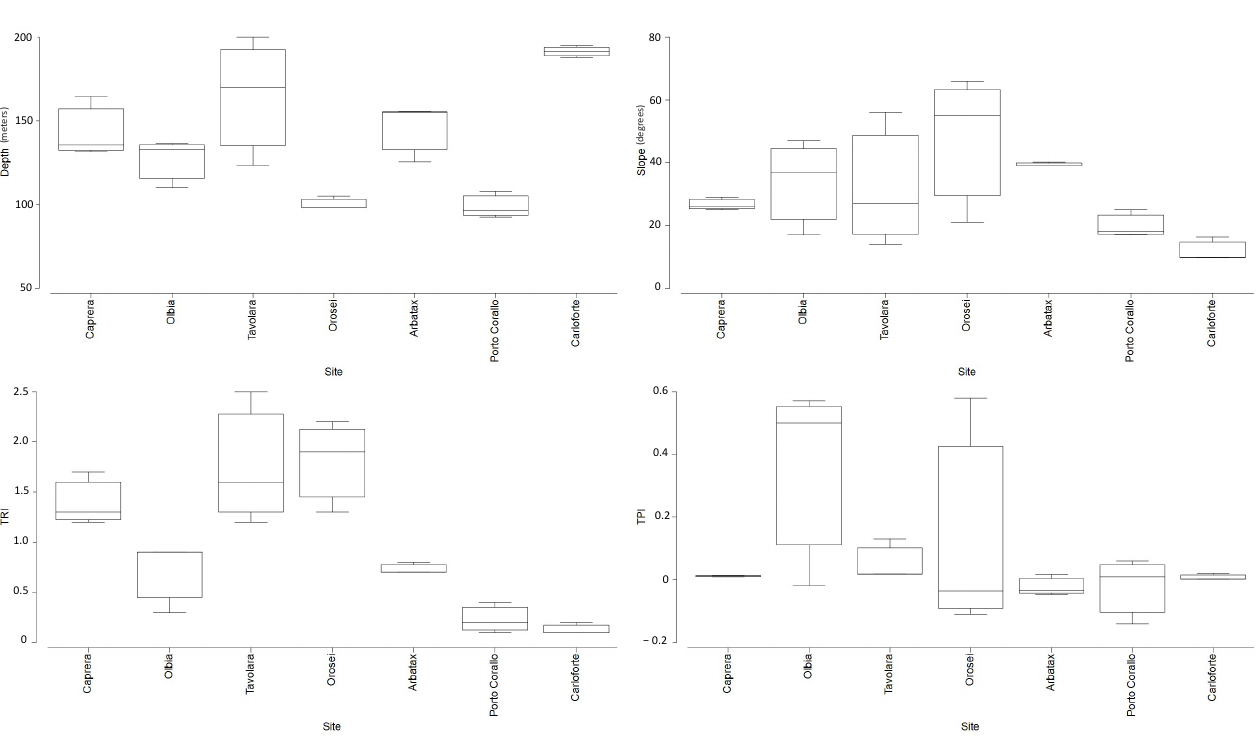
Figure 2. Boxplots showing the geomorphological characteristics of the investigated sites. TRI, terrain ruggedness index; TPI, topographic positioning index .